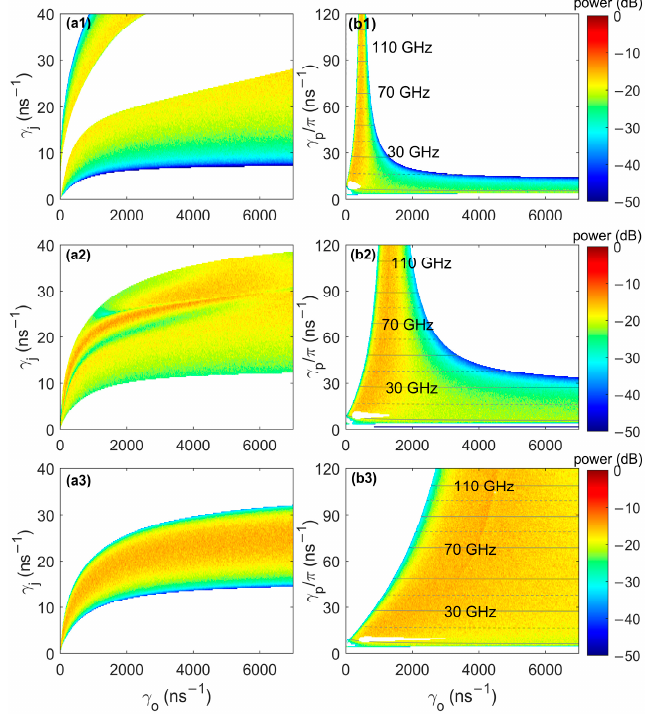
(cid:16) (cid:17) γ o , γ j plane (left column) and